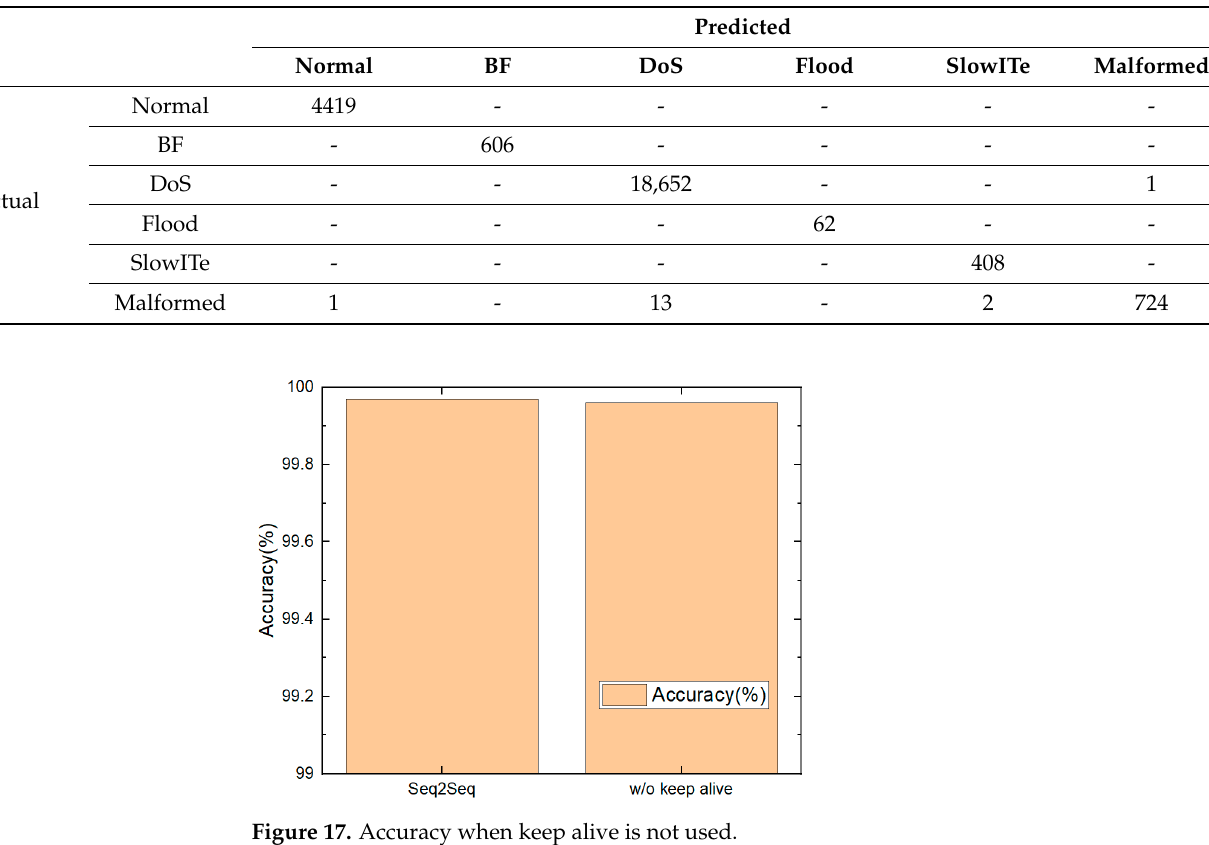
Table 7. Confusion matrix when the message type is not used.